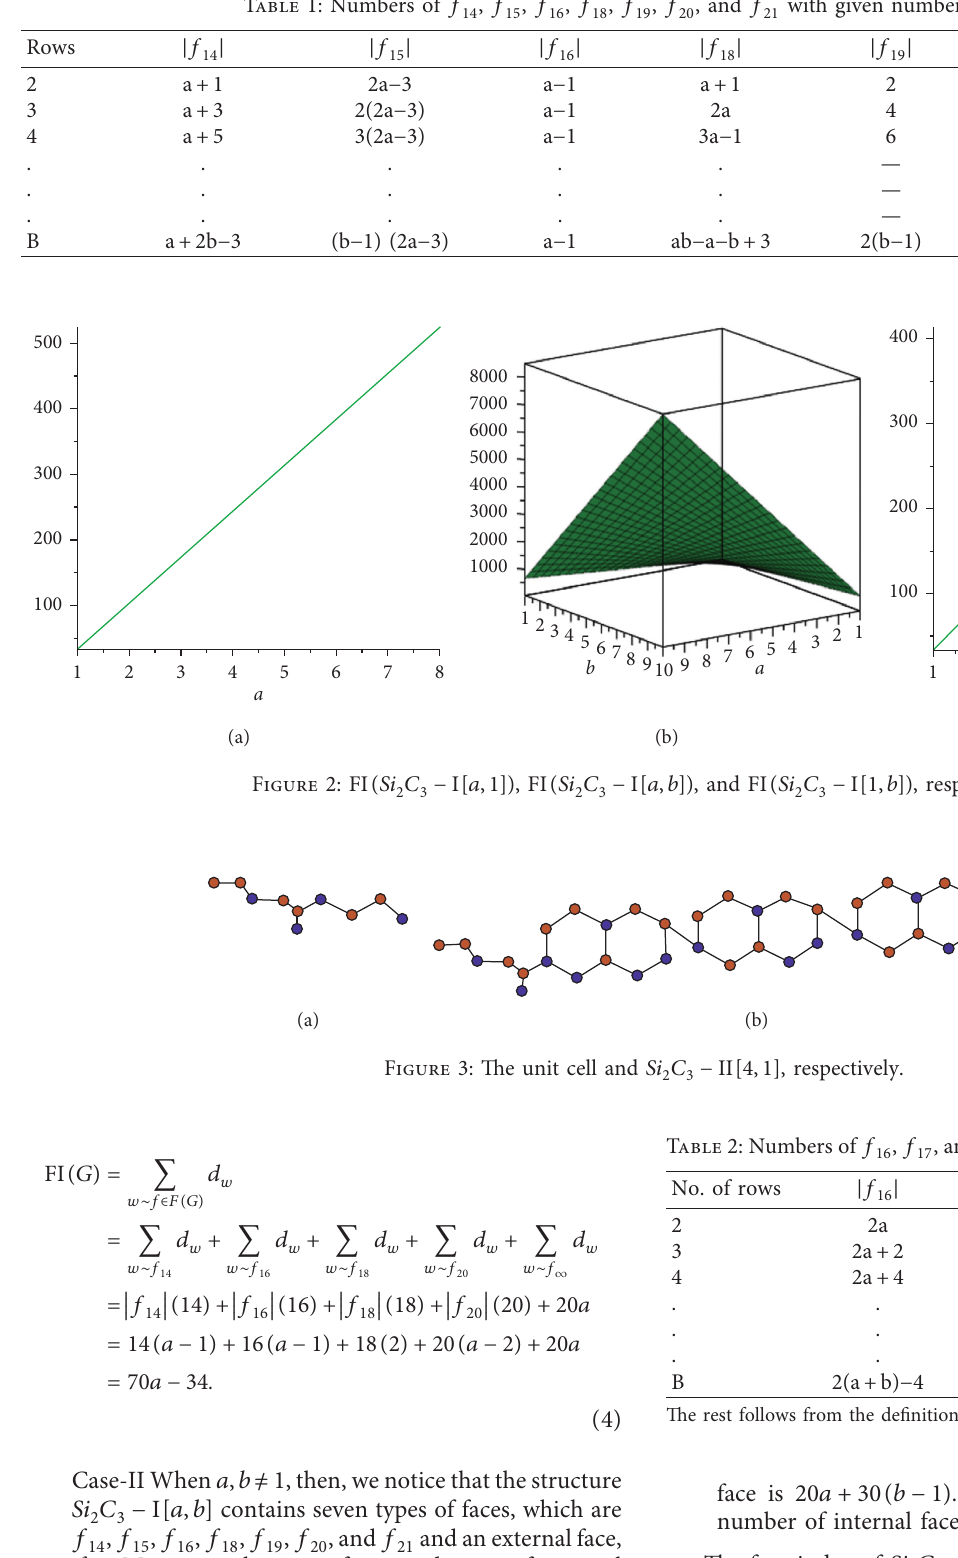
, f , f , f , f , f , and f 14 15 16 18 19 20